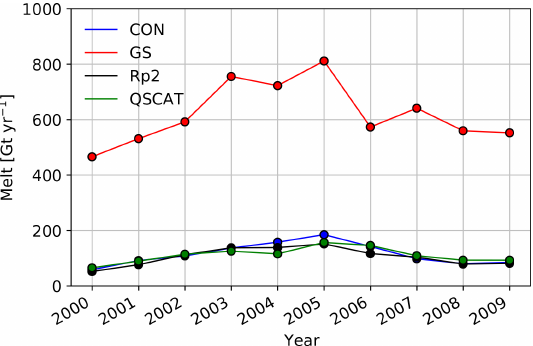
Figure 14. Cumulative melt in mmw.e. at Neumayer calculated by the energy balance model (EBM) of Jakobs et al. (2019) and Rp2, GS and